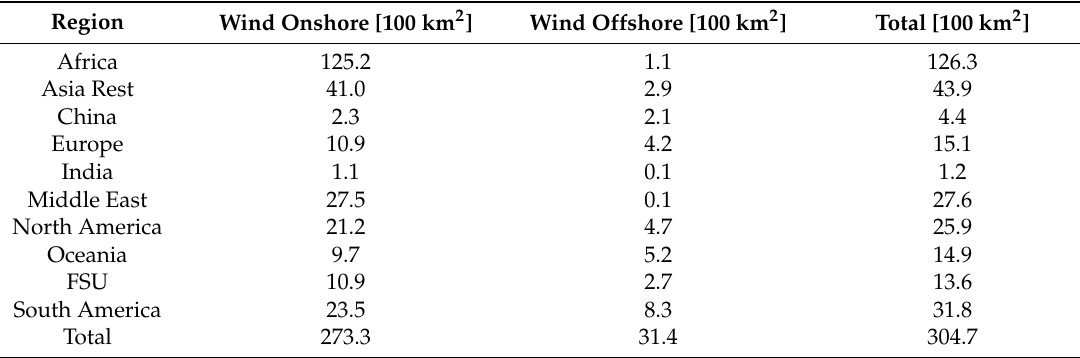
Table 4. Wind—Regional